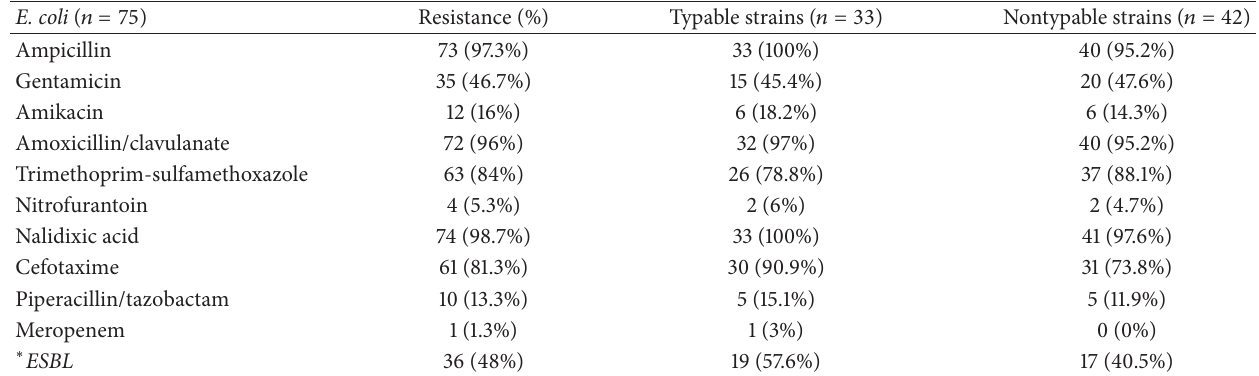
Table 2: Antimicrobial resistance profile among E. coli isolates.